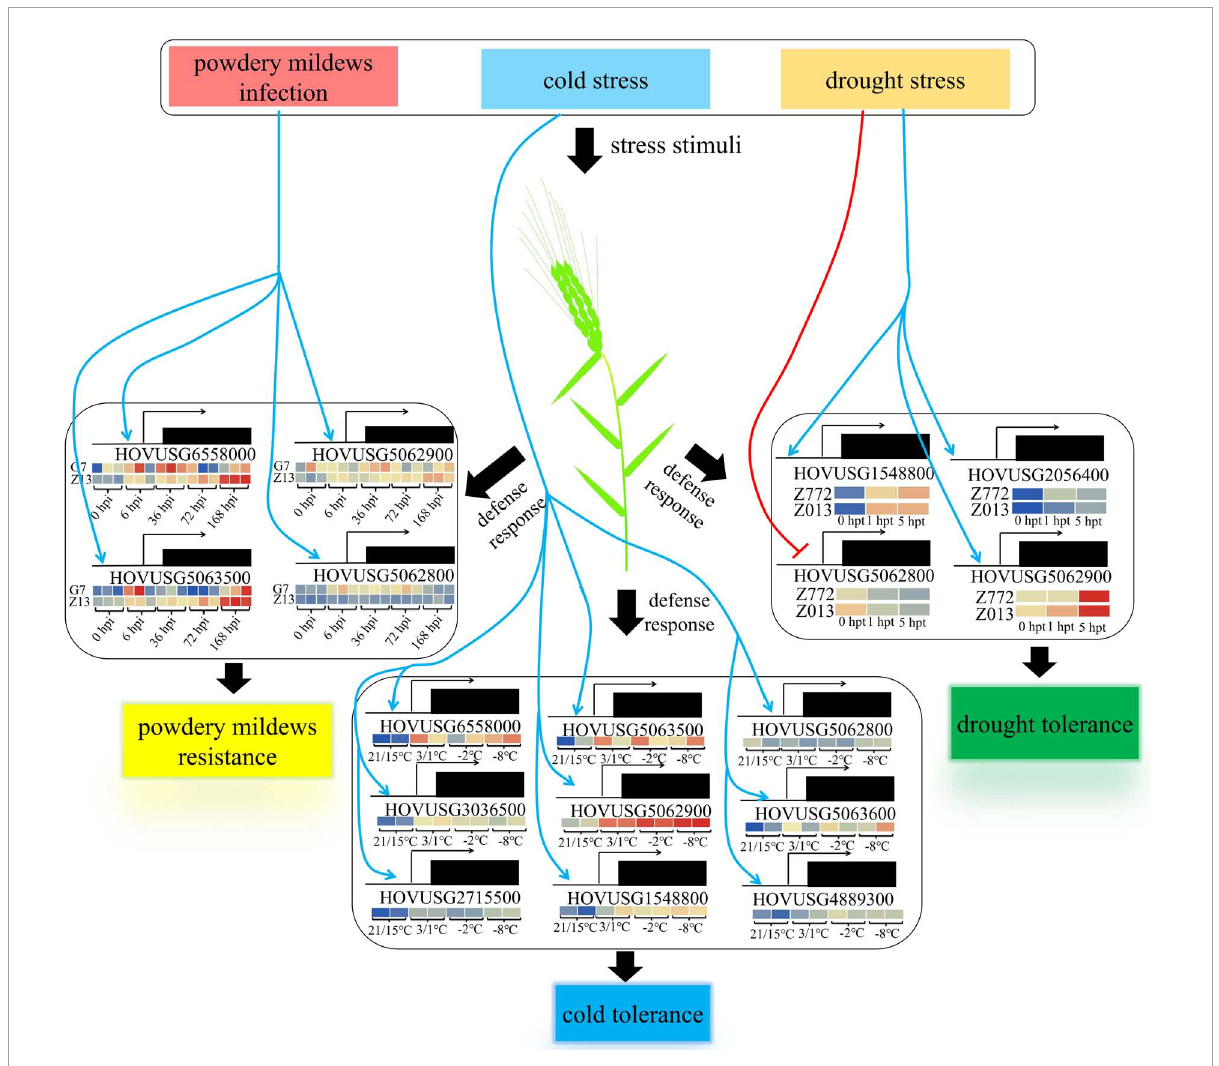
FIGURE9 Proposed working model for TLP -mediated plant defense response in Qingke. Blue arrows indicate the promotion of gene transcription, while the red arrow indicates its negative